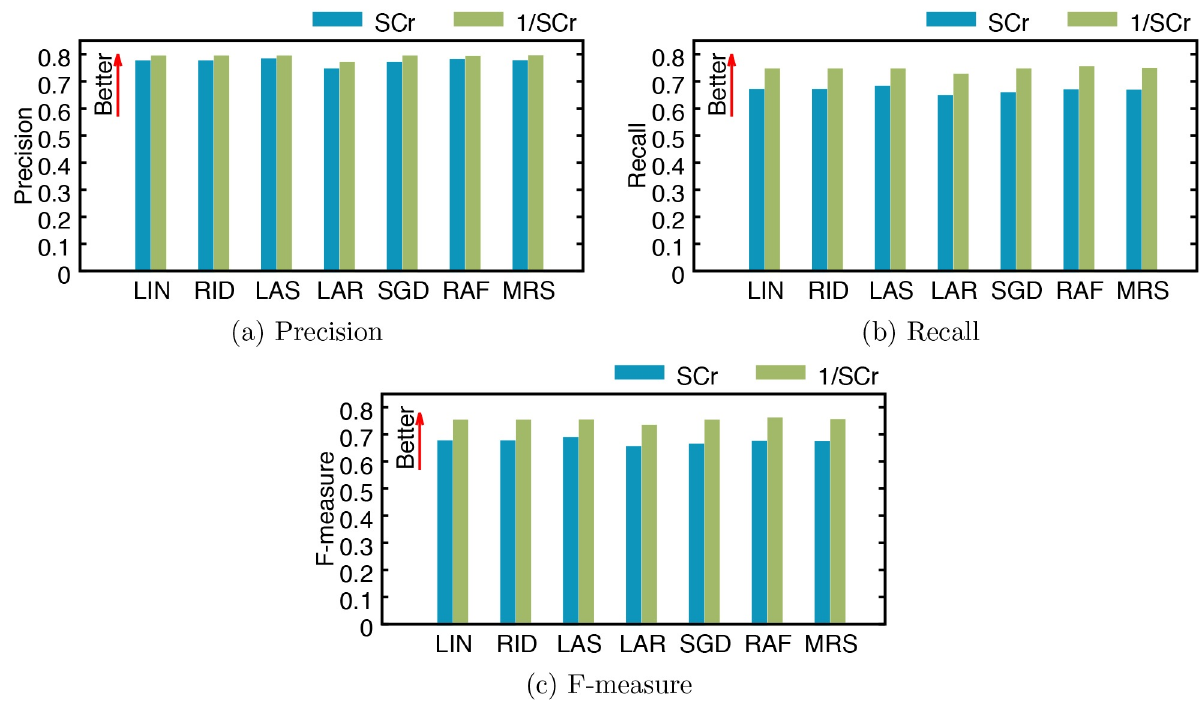
Fig 6. Performance of AKI occurrence classification by several models using SCr and 1/SCr. (a) precision, (b) recall, and (c) F-measure. LIN: linear regression, RID: ridge regression, LAS: lasso, LAR: least-angle regression (LARS), SGD: stochastic gradient descent, RAF: random forest, and MRS: multivariate adaptive regression splines (MARS).